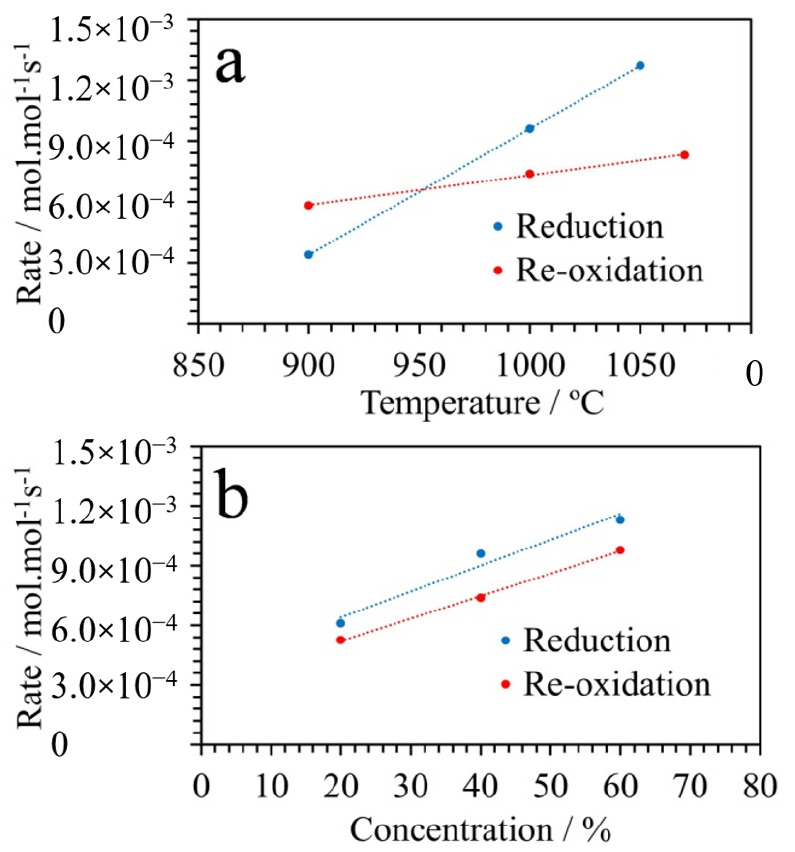
Figure 3. Variation in reaction rates as a function of ( a ) temperature and ( b ) reactant concentration.